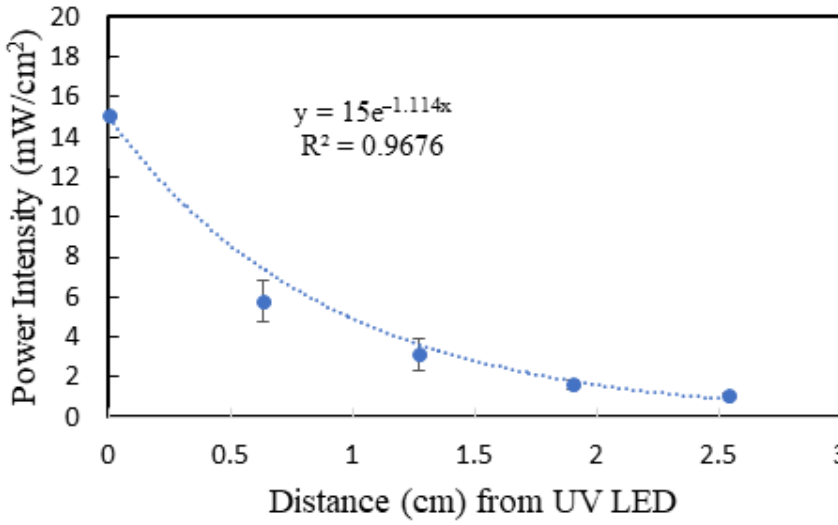
Figure 6. UVA (365 nm) light intensity as a function of distance away from the UV LEDs.